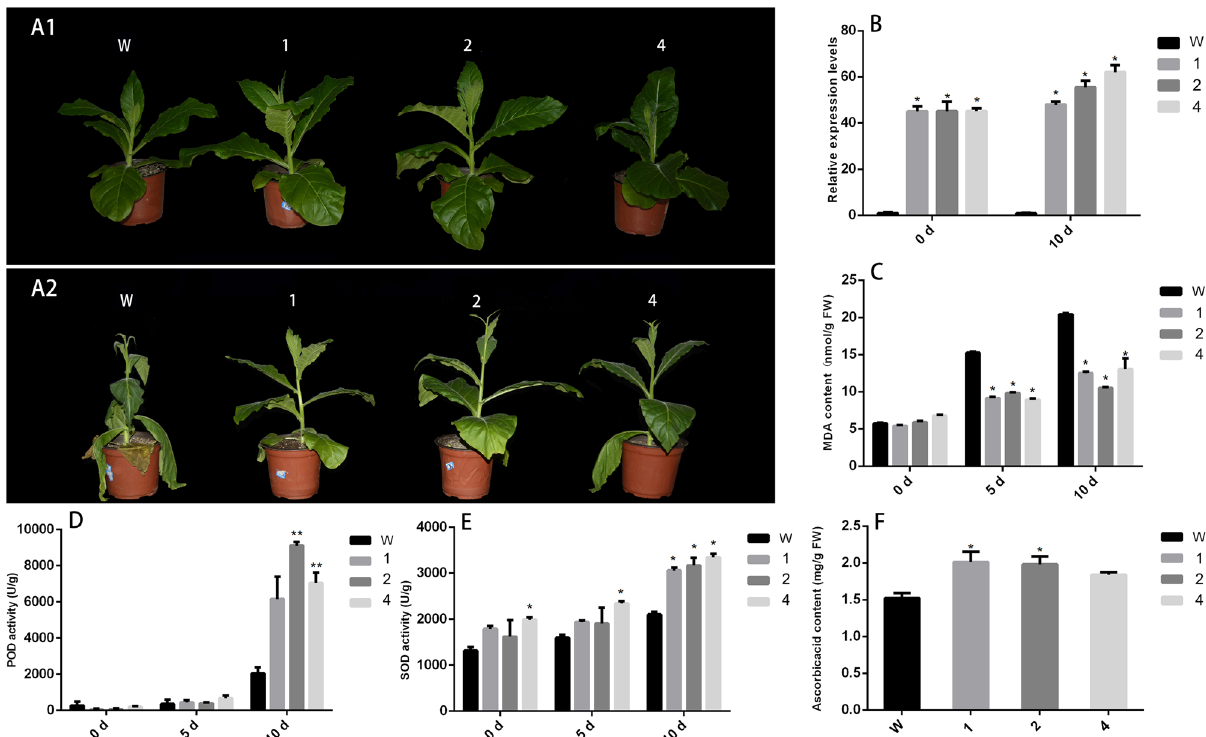
Figure 5. Analysis of drought resistance in wild-type and CvGME transgenic plants. ( A1 ) Plants before drought stress treatment. ( A2 ) Tobacco plants under drought stress for 10 days. W: wild-type tobacco; 1, 2 and 4: T1 generation of three different transgenic lines. ( B ) CvGME expression in tobacco after 10 days drought treatment. ( C ) MDA content. ( D ) Peroxidase (POD) activity. ( E ) Superoxide dismutase (SOD) activity. ( F ) AsA content of wild-type and CvGME transgenic plants. Data showed as mean ± SD of three independent experiments. Asterisks indicate values that are significantly different from those of the wild-type plants (** p < 0.01 or * p <